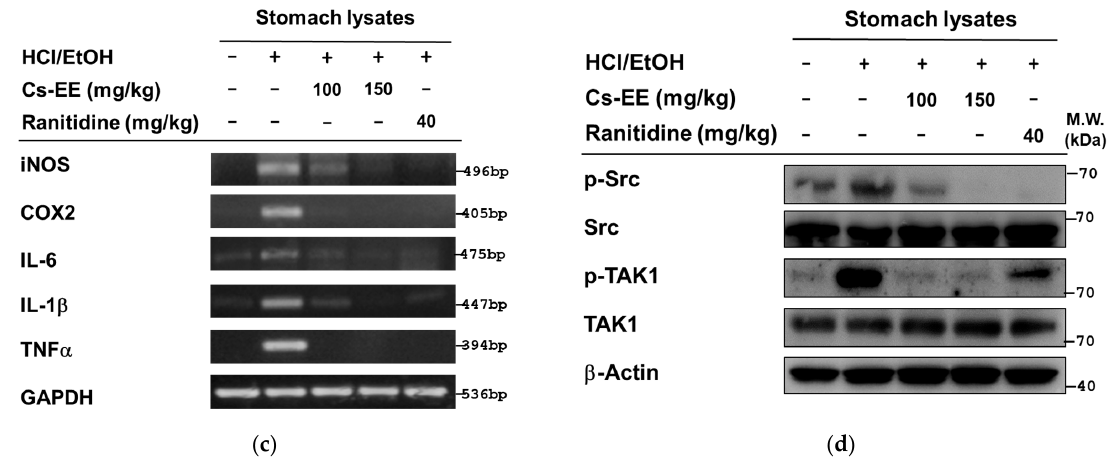
Figure 6. Effects of Cs-EE in the in vivo HCl/EtOH-induced acute gastritis models. ( a ) Schematic of HCl/EtOH-induced acute gastritis protocol. Fasted ICR mice were orally administrated with 100 μ L different solutions based on different groups: normal group (0.5% CMC), HCl/EtOH group or as control group (0.5% CMC), Cs-EE groups (100 and 150 mg/kg Cs-EE) and ranitidine group (40 mg/kg ranitidine) three times in two days, and 150 mM HCl/60% EtOH was orally administrated (200 μ L/mouse) 1 h before sacrifice. ( b ) The representative photograph of gastric inflammatory lesions, which then was quantified by ImageJ. Results ( b ) are expressed as mean ± SD (n = 5). ### p < 0.001 compared to normal group, and *** p < 0.001 compared to control group (inducer alone). A p-value was analyzed using the student’s t -test. ( c ) The expression of inflammatory genes in stomach lysates was analyzed by semiquantitative RT-PCR. ( d ) The phospho- and total forms of Src, TAK1, and β -actin were evaluated by immunoblot analysis.